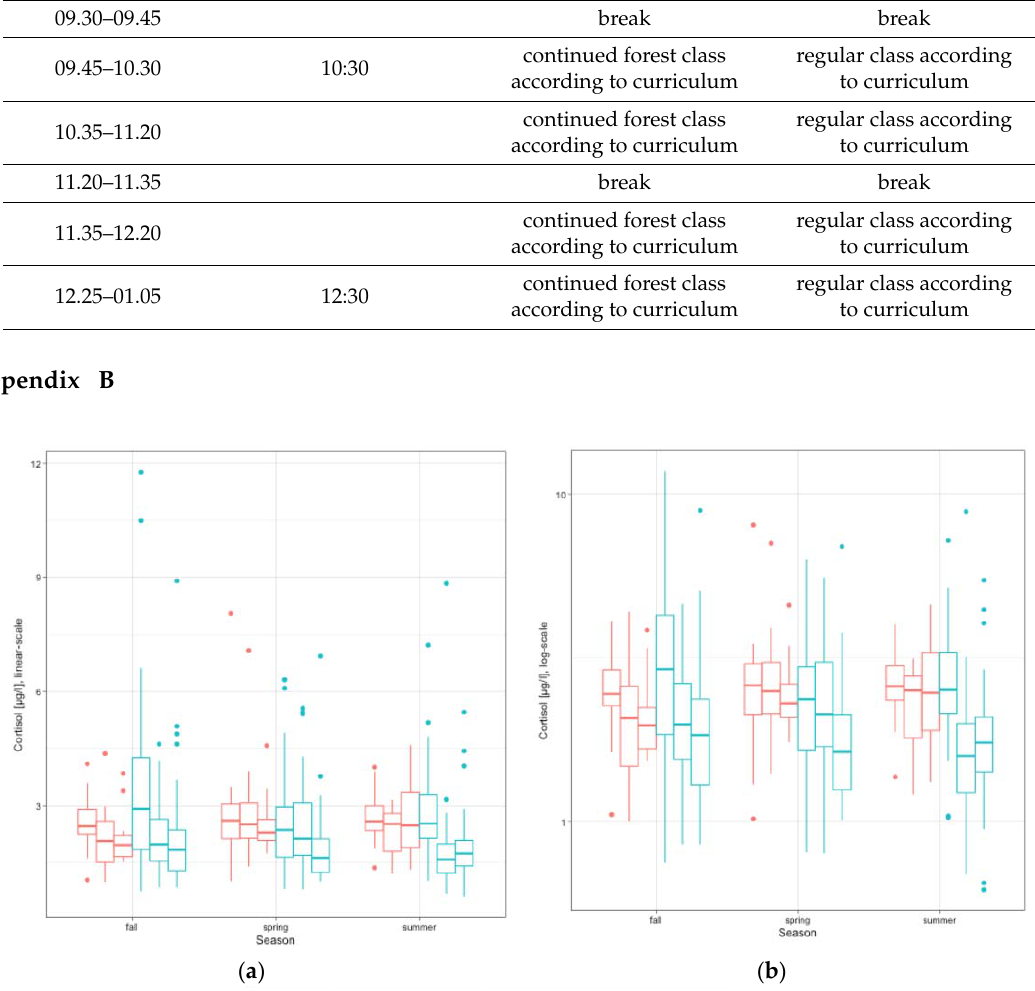
( c ) Figure A1. Cortisol raw values compared to log10-transformed cortisol values. Displayed are ( a ) the raw cortisol values on the three time-points (8:30, 10:30, 12:30) at the three seasons (fall, spring, summer) in both groups (control = red, intervention = green). Panel ( b ) shows the same data with a logarithmized y-axis and ( c ) the logarithmized cortisol-values on a linear y-scale. It can be seen that by log-transforming the y-scale ( b ), some outliers can be eschewed, and that by logarithmizing the cortisol-values ( c ), the variance, skewness, and kurtosis of the data can be reduced (c.f. Table A1). Table A2. Descriptives for logCortisol and Cortisol. Cortisol